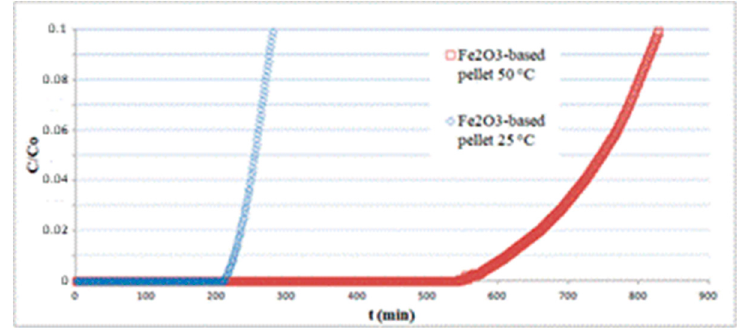
Figure 8. Effect of temperature on the performance of a hematite-based pellet bed. Figure 8. E ff ect of temperature on the performance of a hematite-based pellet